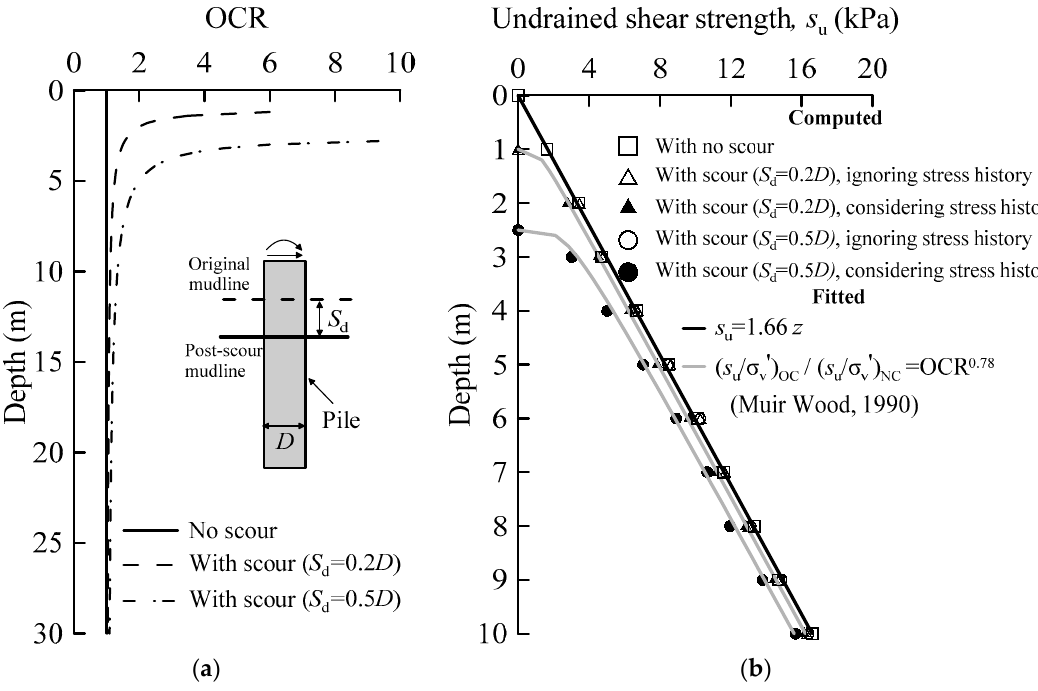
Figure 6. Distribution of: ( a ) overconsolidation ratio; ( b ) undrained shear strength with depth.